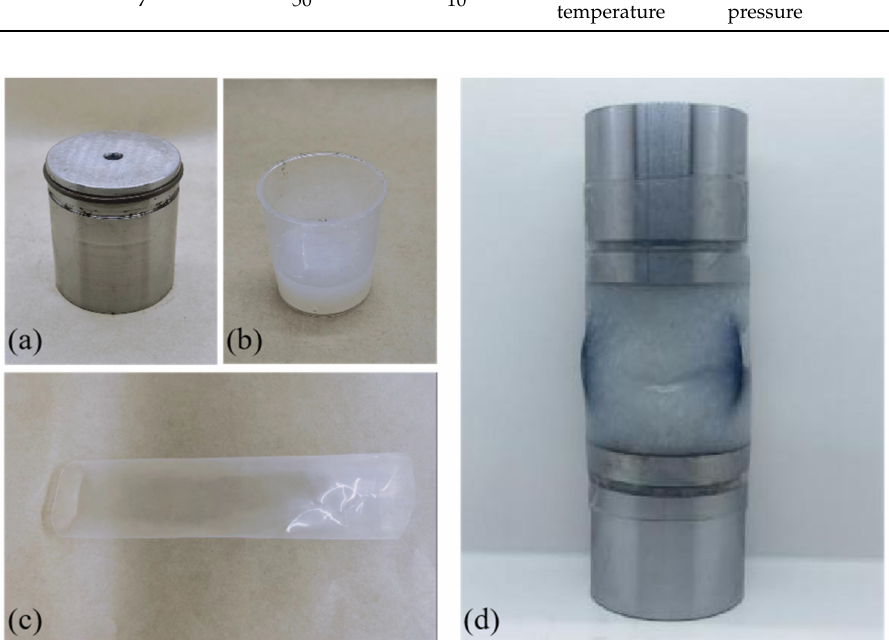
Figure 4. Preparation of sealed cement stone specimens: ( a ) cylinder indenter, ( b ) silica gel, ( c ) heat shrinkable tube with high temperature resistance and ( d ) sealed